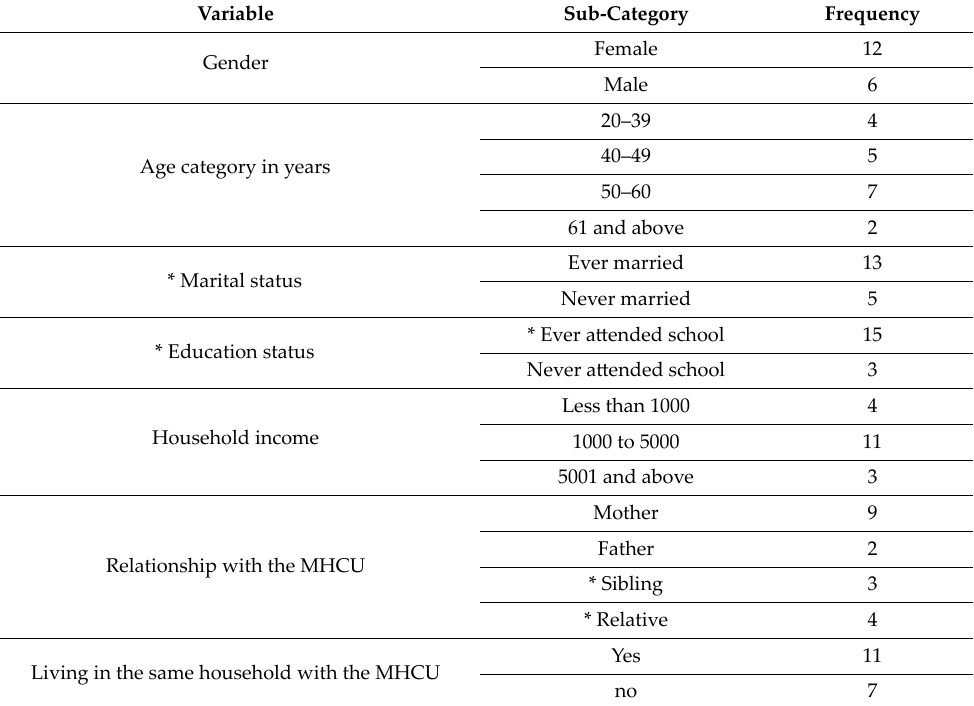
Table 1. Sociodemographic characteristics of the primary caregivers of MHCUs sample for this